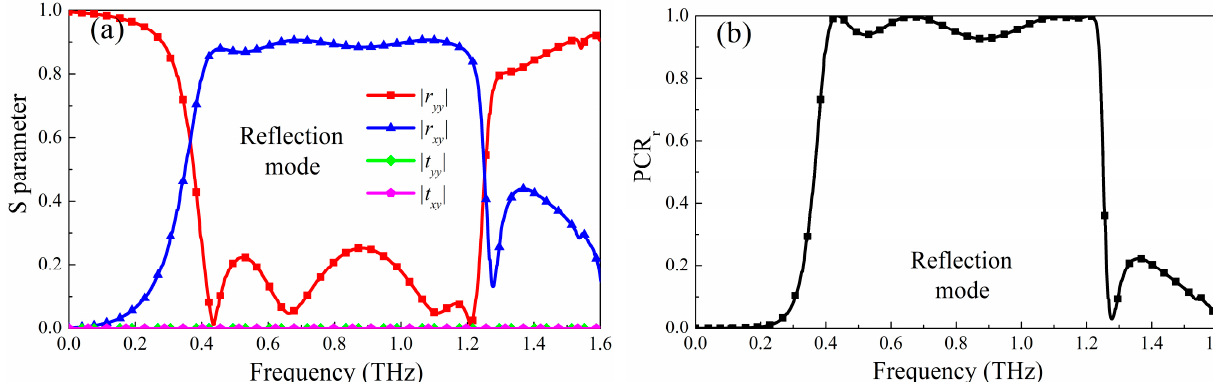
Figure 2. The Simulated results of reflection operating mode ( a ) S parameter; ( b ) PCR r .